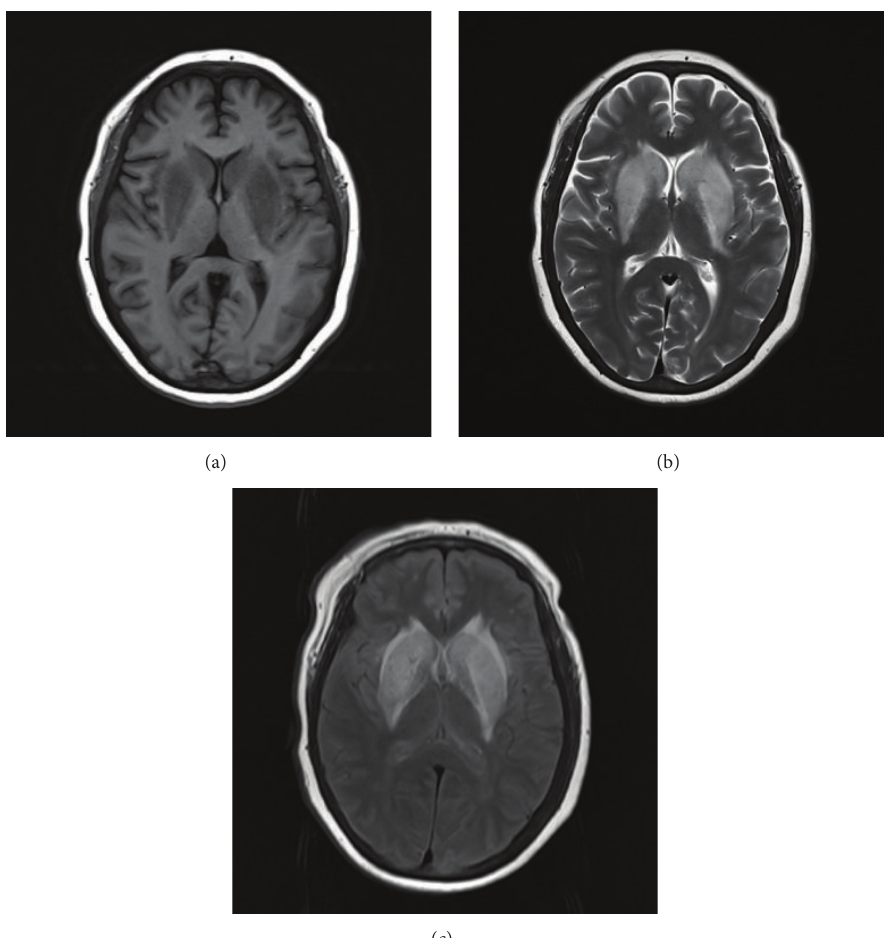
Figure 2: (a, b) The lesions extended in both T1WI and T2WI after 3 weeks. (c) FLAIR images showed demyelination around bilateral ventricles and lacunar